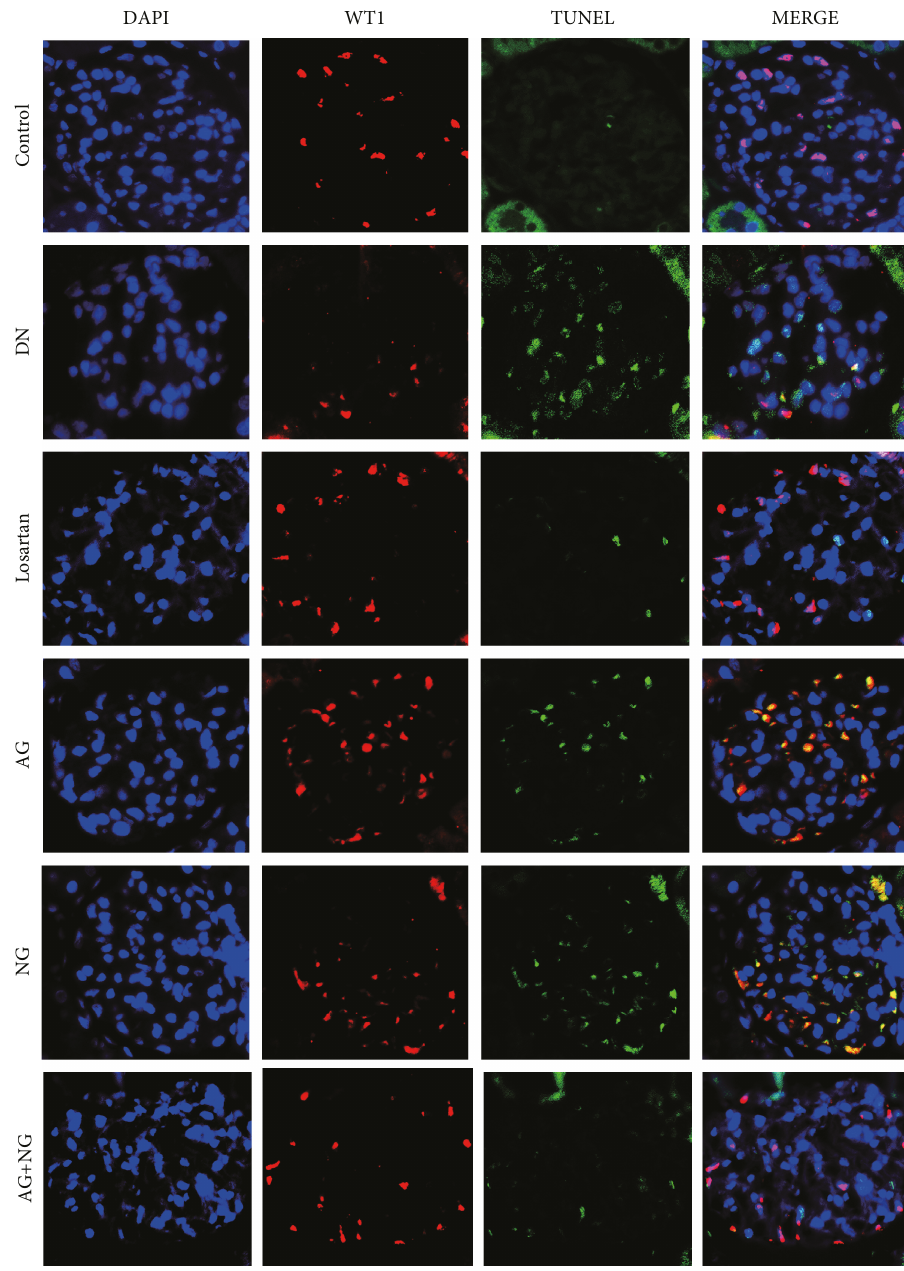
Figure 5: E ff ects of AG and NG on podocyte apoptosis in diabetic rats. The triple-positive cells, WT1 (red), TUNEL (green), and DAPI (blue), were identi fi ed as the apoptotic podocytes. Control: normal control rats; DN: STZ-induced diabetic rats; losartan: DN rats treated with losartan; AG: DN rats treated with Astragalus membranaceus; NG: DN rats treated with Panax notoginseng; AG+NG: DN rats treated with Astragalus membranaceus plus Panax